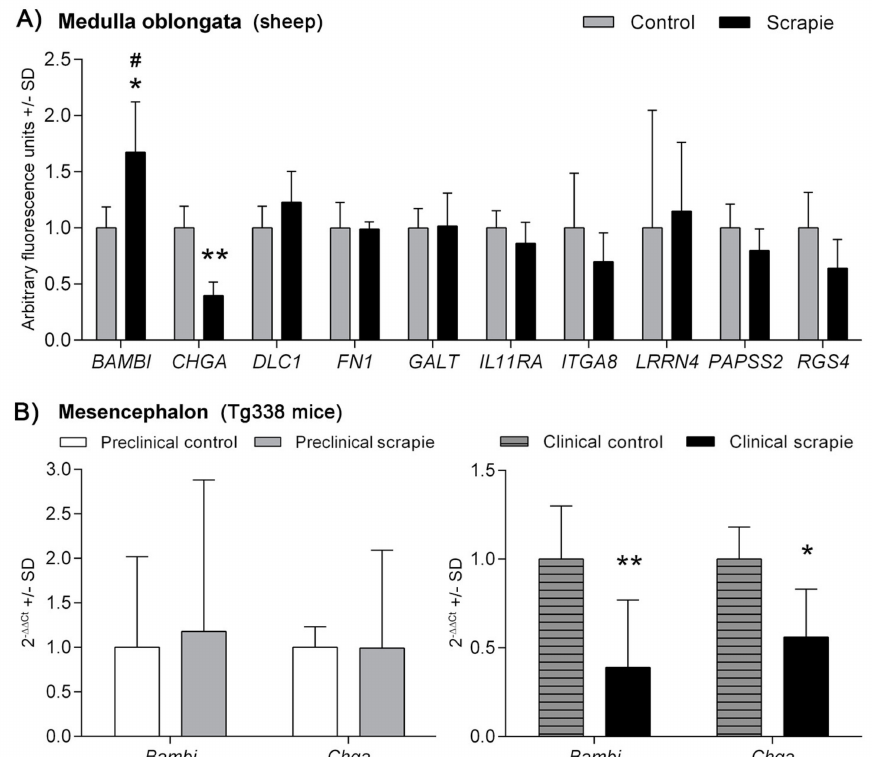
Figure 1. mRNA expression profiles of prion replication-related genes in ( A ) the medulla oblongata of sheep naturally-infected with scrapie (black bars) and control animals (grey bars) and in ( B ) mesencephalon of preclinical (grey bars) and clinical (black bars) scrapie-infected Tg338 mice. White bars and grey-striped bars display expression levels in controls for preclinical and clinical mice, respectively. Relative expression levels are expressed as means ± standard deviation. Relative expression values ( y -axis) are expressed as arbitrary units. Results were normalized using the geometric mean of the expression of G6PDH , GAPDH and HPRT housekeeping genes in sheep and the expression of Sdha and H6pd in Tg338 mice. Di ff erences between groups were evaluated with the Student´s t -test (* p < 0.05 and ** p < 0.01). Significant di ff erences after Bonferroni correction for multiple tests are shown as # p <